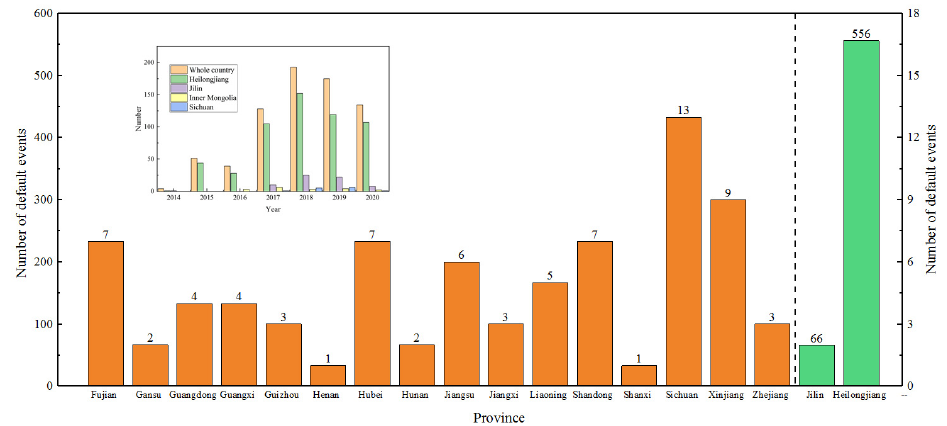
Figure 2. Number of default events of farmland mortgages during 2014–2020. Table 1. The default amount and proportion of farmland mortgages.